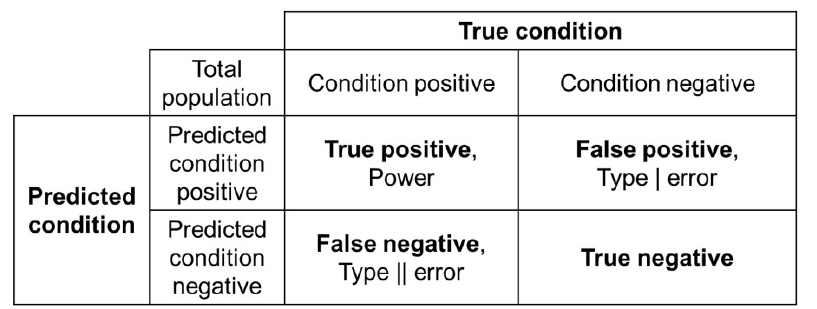
Figure 6. Calculation of the performance metrices by confusion